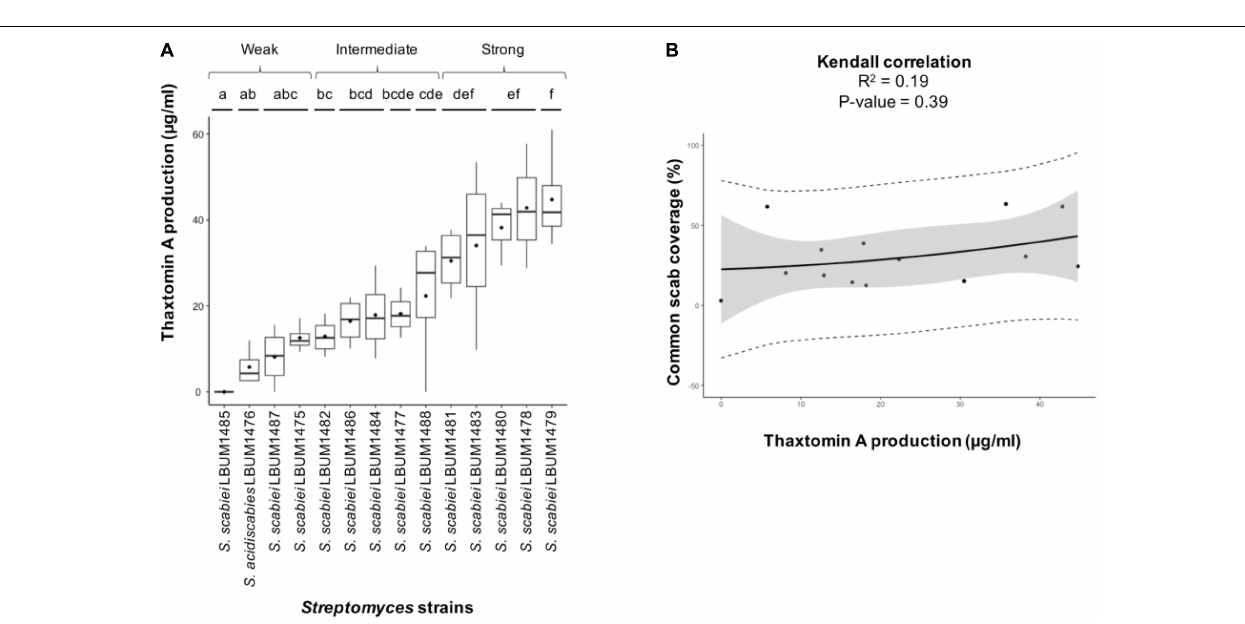
FIGURE 3 | Comparative analysis of the organization of the pathogenicity island between the fourteen scab-causing Streptomyces spp. used in this study. Each color corresponds to a gene or a cluster of genes homologous between the fourteen strains.